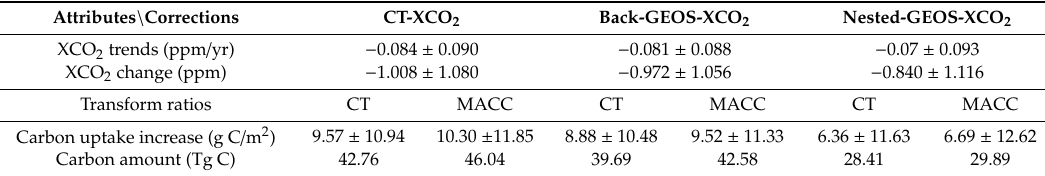
Table 2. GM-XCO 2 decreasing trends and estimated CO 2 uptake changes from 2003 to 2015 during the vegetation growing period over Eastern China (EC). There are results from three di ff erent XCO 2 background corrections and two flux-XCO 2 transform ratios. XCO 2 background corrections are shown in Section 3.2. Transform ratios are shown in Figure 7. Uncertainties in XCO 2 trends and changes refer to 1 standard deviation of spatial grid-scale variability in